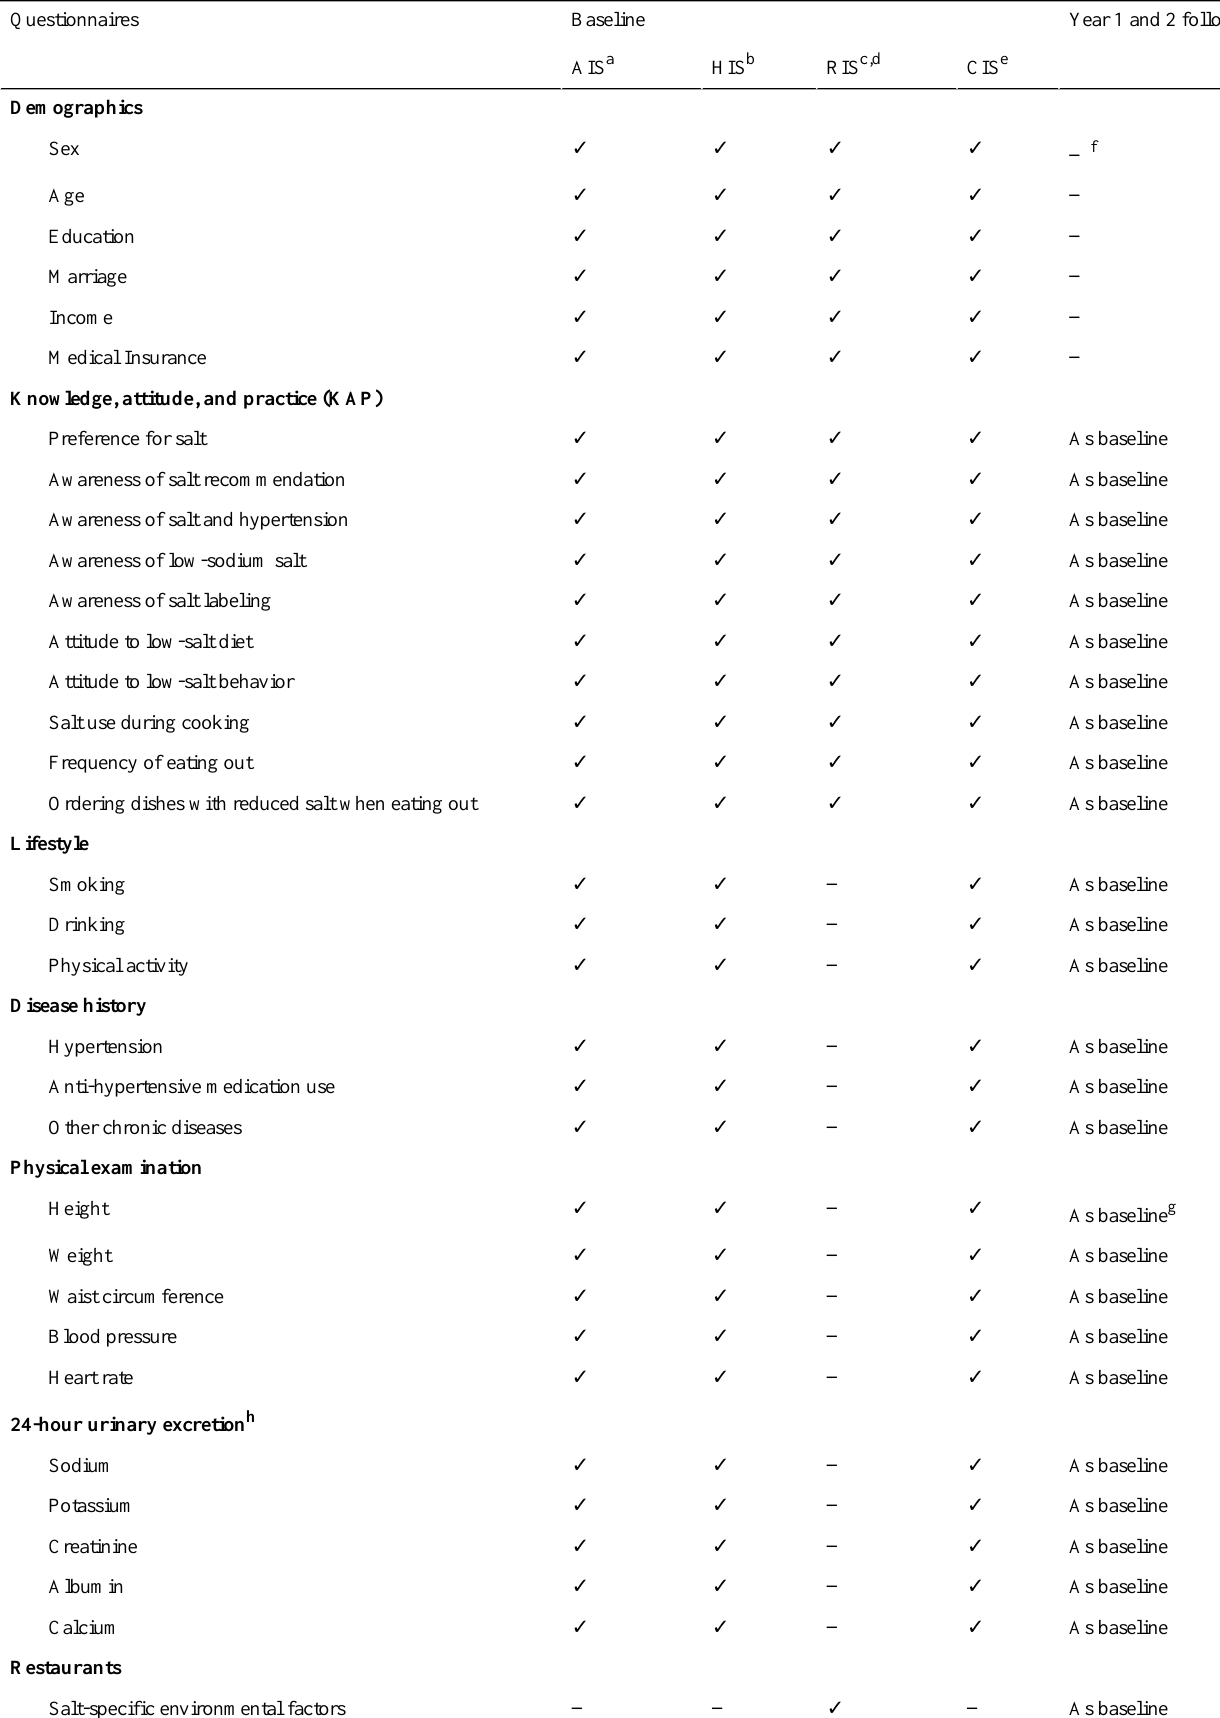
Table 2. Data collection in the four randomized controlled trials in Action on Salt China (ASC) Programs 2-5.